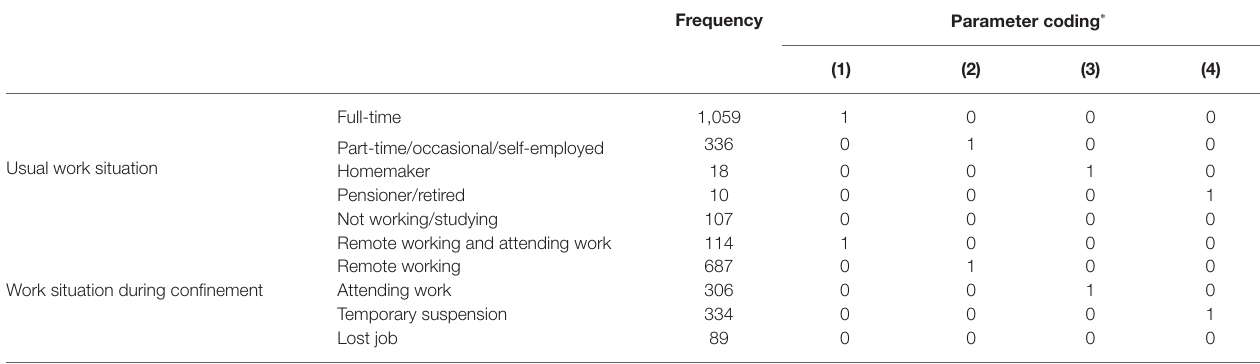
TABLE 7 | Frequencies and parameter (1) coding for the categorical variables related to the work situation included in the regression